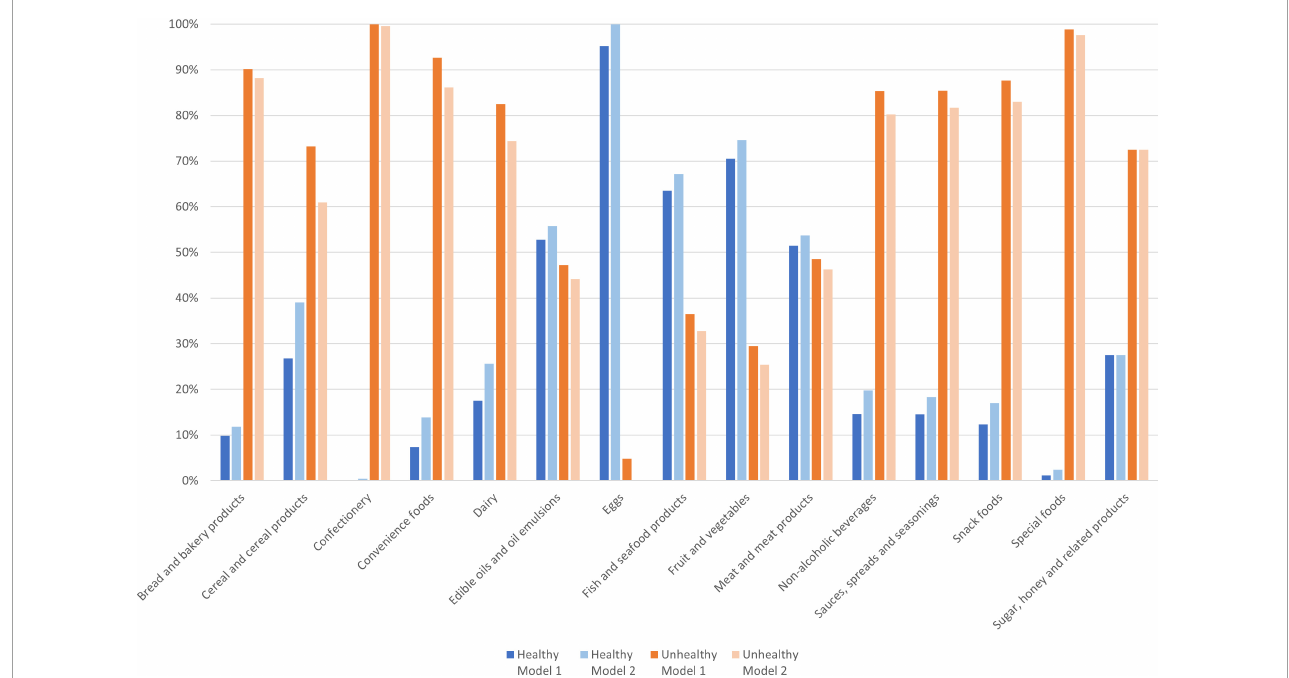
FIGURE2 Proportion of food items ( n = 7,322) classified as healthy and unhealthy by Model 1 and Model 2, by